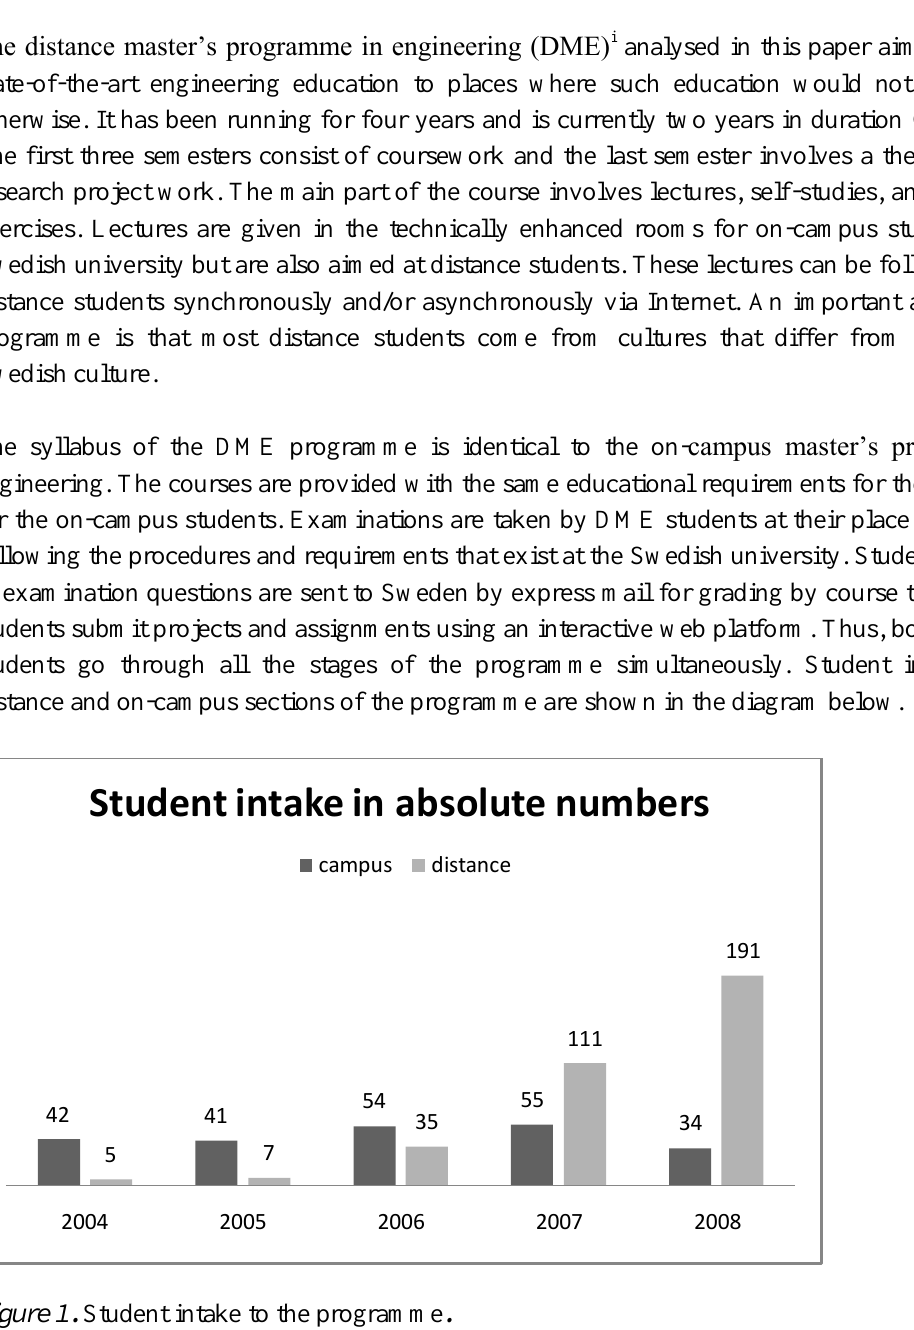
Figure 1. Student intake to the programme